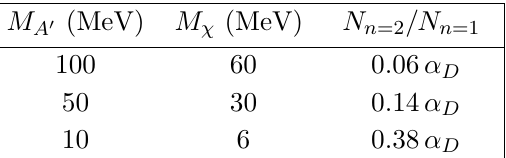
0 emission relative to single- A 0 emis-